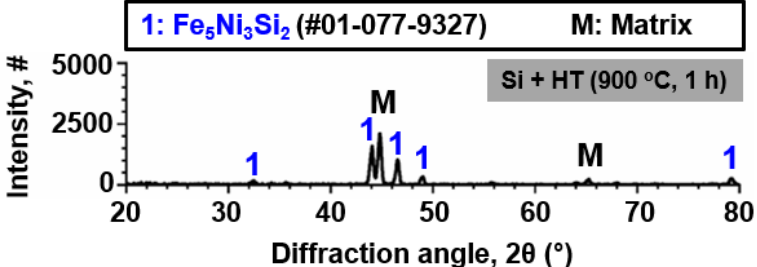
Figure 1. Result of X-ray diffraction (XRD) analysis conducted on the surface-modified (Si-coated and heat-treated) SS 316LN.